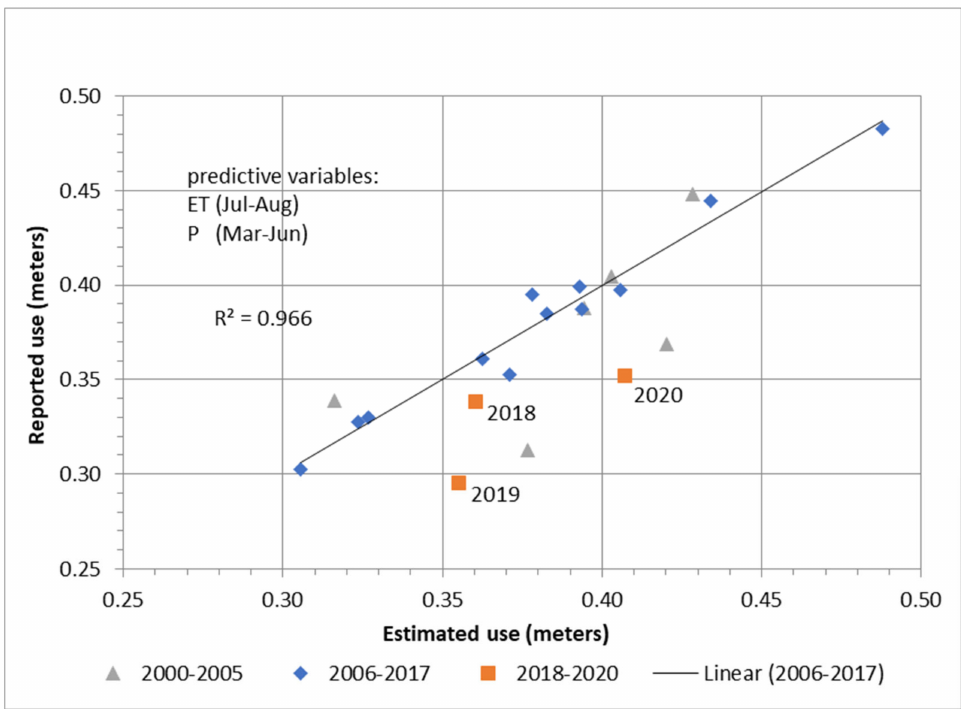
Figure 5. GMD No. 3 average reported vs estimated water use per unit area for 2006–2017 (base period), 2000–2005, and 2018–2020. See Appendix A for